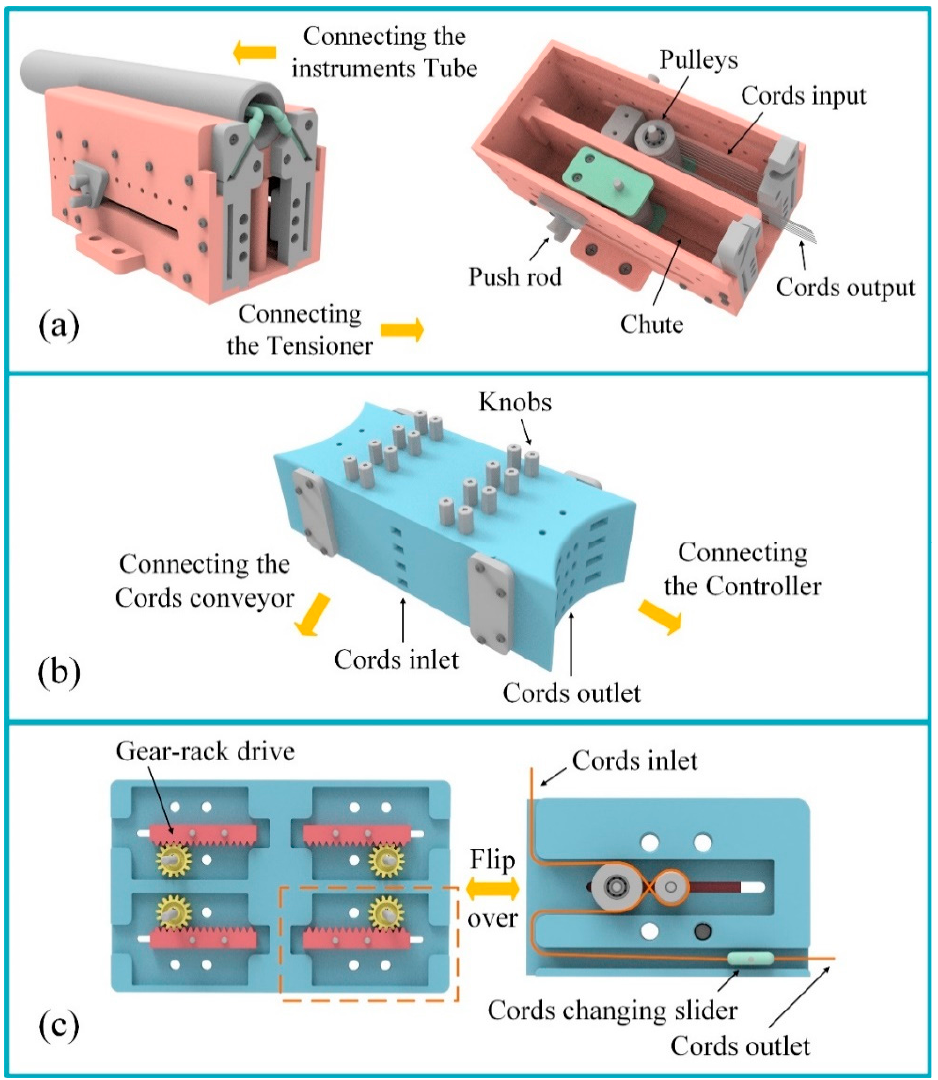
Figure 5. Structure of cords conveyor and tensioner: ( a ) the cords conveyor; ( b ) the tensioner; ( c ) schematic diagram of the tensioning module structure.